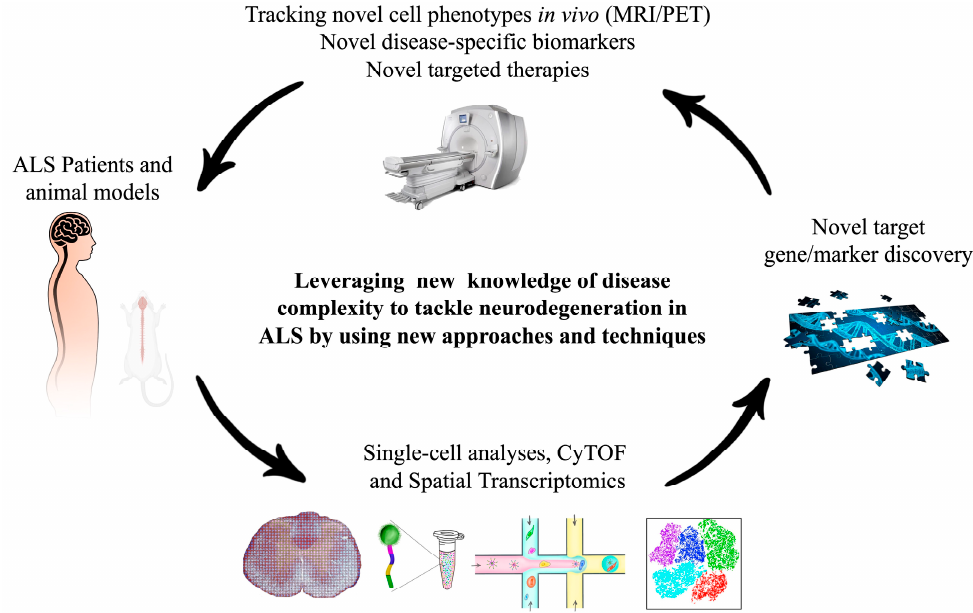
Figure 2. Strategies to investigate the complex microglia signature in ALS include single-cell and spatial transcriptomics approaches or multi-omics techniques such as cytofluorometry by time-of- flight (CyTOF). These will allow to identify novel targets that could be exploited therapeutically or for magnetic resonance imaging (MRI)/positron emission tomography (PET) imaging studies.